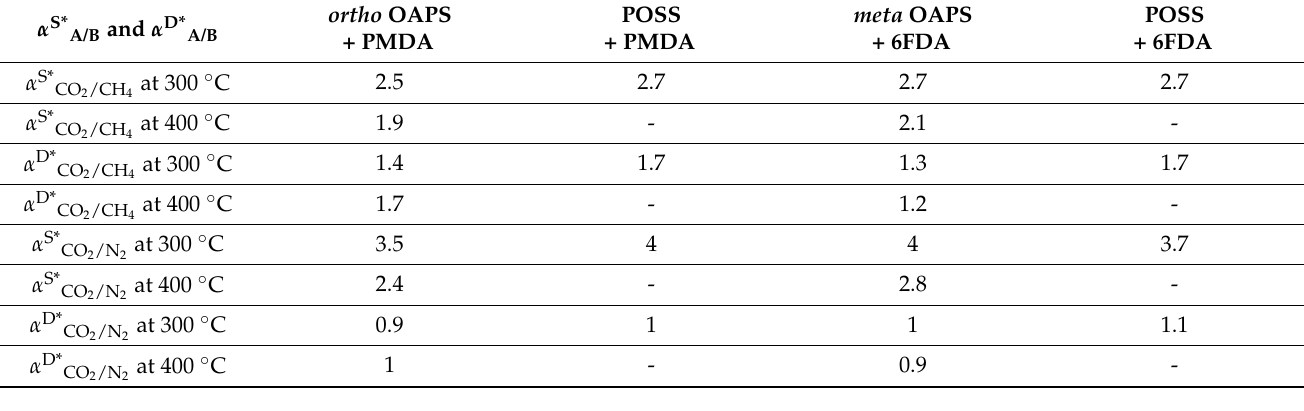
Table 8. Real solubility and diffusion selectivities for the CO 2 /CH 4 and CO 2 /N 2 gas pairs in the selected polyOAPS/POSS-imides, at both 300 ◦ C and 400 ◦ C and at 90%/10% CH 4 /CO 2 and N 2 /CO 2 feed pressures of 60 bar. The maximum standard error is less than 0.2 for all the selectivities.